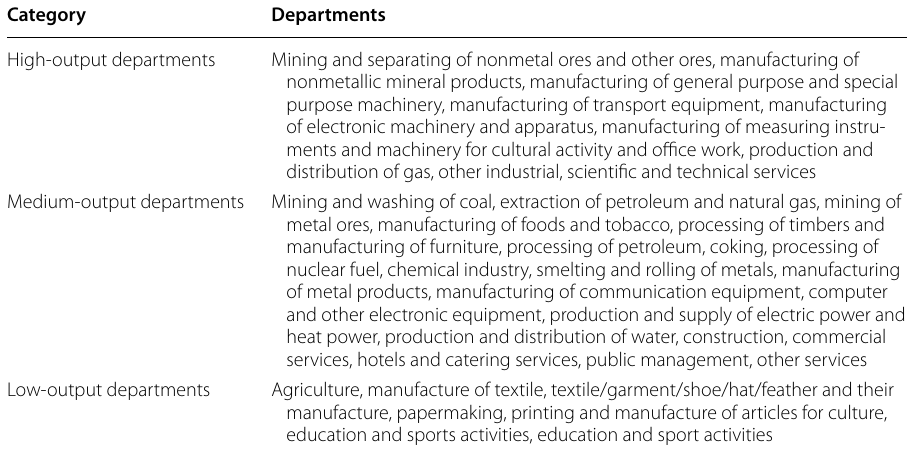
Table 4 Various industrial departments’ direct water consumption efficiency (for the year 2013 as an example)